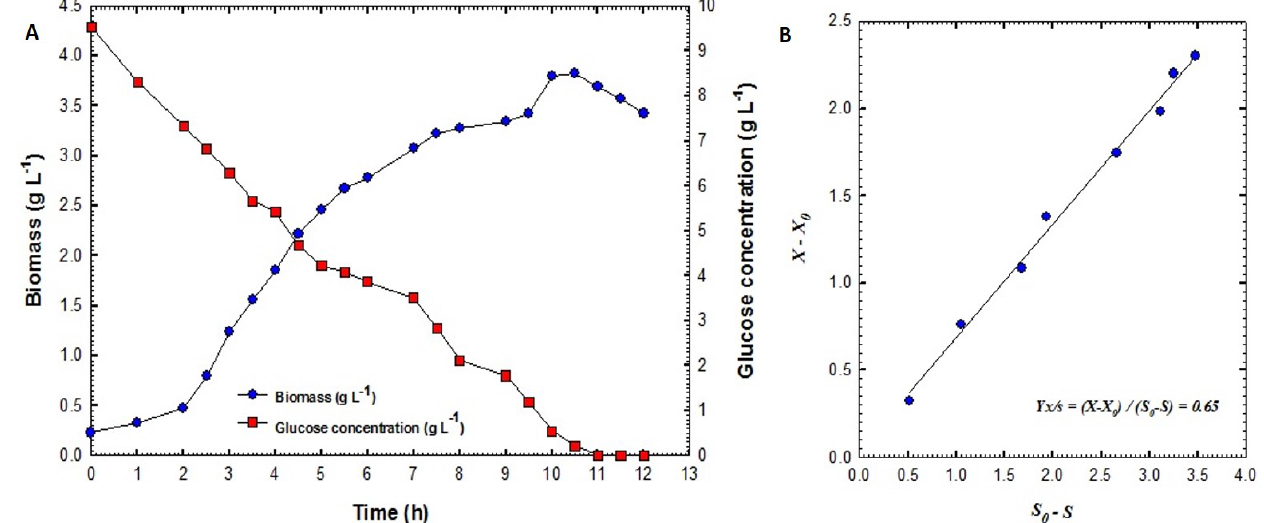
Figure 2. ( A ) Biomass and glucose concentration of fermentation broth as a function of time for batch fermentation of Bacillus velezensis strain GB1, and ( B ) yield coefficient for growth of Bacillus velezensis strain GB1on glucose. X 0 represents the cell mass in the broth at initial time t 0 (g L −1 ); X, the cell mass concentration in the broth at time t (g L −1 ); S 0 , glucose concentration in the broth at initial time t 0 (g L − 1 ); and S, glucose concentration in the broth at time t (g L − 1 ).